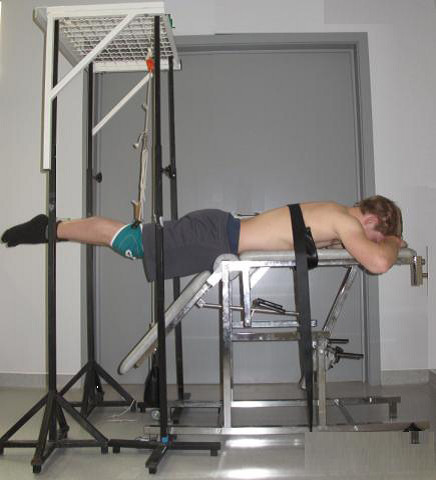
Position leg extension exercises.